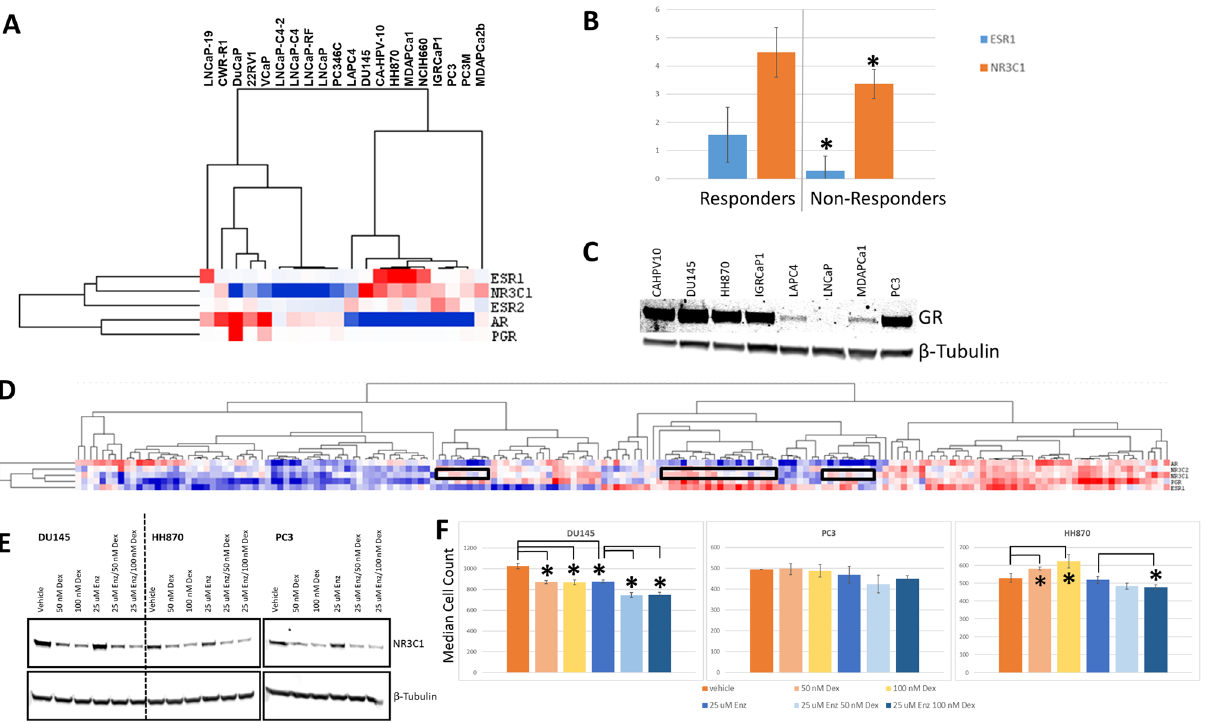
Figure 4. Expression of other NR3 family members in prostate lines and assessment of GR as a potential target in prostate cancer cell lines. ( A ) Expression of NR3 nuclear receptors in the prostate cancer cell line. NR3C1 expression is largely inversely correlated with AR expression. ( B ) Expression of ESR1 (blue) or NR3C1 (orange) in AR-null responders (left) or non-responders (right) to enzalutamide, showing that the expression of both of these family members is significantly higher in the cell lines that responded to enzalutamide ( p < 0.05). ( C ) Western blot analysis of glucocorticoid receptor in a subset of the prostate cell lines. Note expression was positive in all of the lines tested except for the AR positive cell line LNCaP. Full, unaltered blots are available in supplementary Fig. S1. ( D ) Expression of NR3 family members in the TCGA panel of prostate cell lines. Distinct clusters are evident, including tumors that lack expression of AR but show strong expression of NR3C1 (boxes). ( E ) Treatment of cells with dexamethasone (50 or 100 nM) results in down-regulation of GR protein, including in the presence of enzalutamide, in DU145, HH870, and PC3 cells. ( F ) Dexamethasone treatment significantly impacts cell growth and enzalutamide response in DU145 and HH870 cells (significant differences marked with bars to show comparisons tested and * to indicate significance). Treatment with either 50 or 100 nM dexamethasone inhibits the growth of DU145 cells (peach and yellow colored bars, p < 0.001), similar to the treatment with enzalutamide (blue bar, p < 0.001). Addition of dexamethasone to enzalutamide (light blue and dark blue bars) result in significant growth inhibition compared to enzalutamide alone ( p < 0.001 in both cases). In HH870 cells, dexamethasone treatment (peach and yellow colored bars, p < 0.005) enhances cell growth compared to control. Treatment with 100 nM dexamethasone (dark blue bar) results in significant growth inhibition compared to enzalutamide alone ( p < 0.05). Treatment with 50 nM dexamethasone plus enzalutamide also shows a trend towards enhancing response ( p =